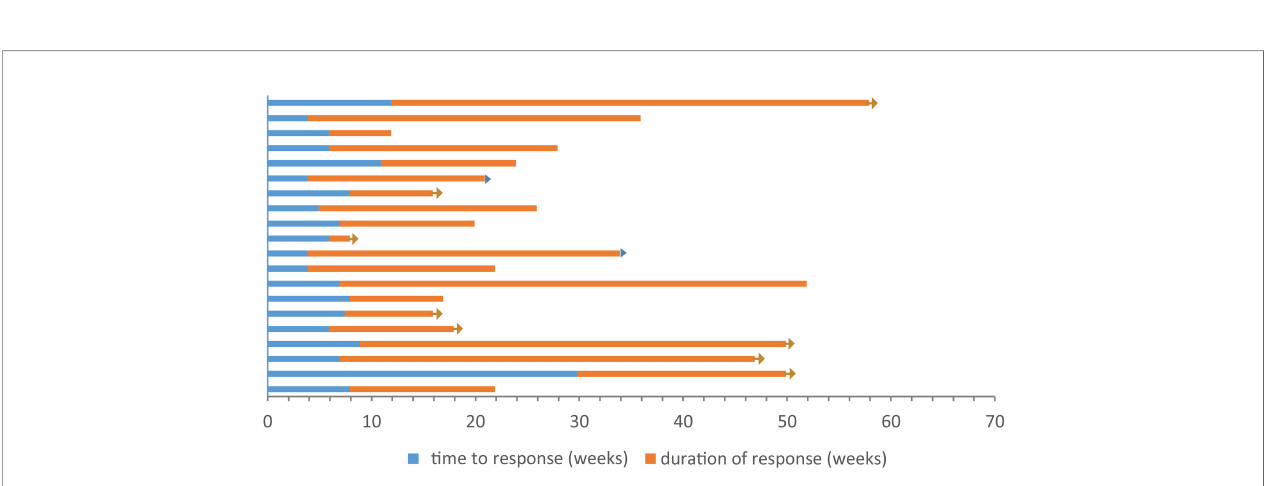
FIGURE 3 | Waterfall plot shows the response of targeted tumor (mRECIST). Green box: CR; blue box: PR; grey box: SD; orange box: PD. Dashed lines indicate thresholds for PR (less than 30%) or PD (>20%). patient had vertebral metastasis; Patients had nontargeted tumor survival.